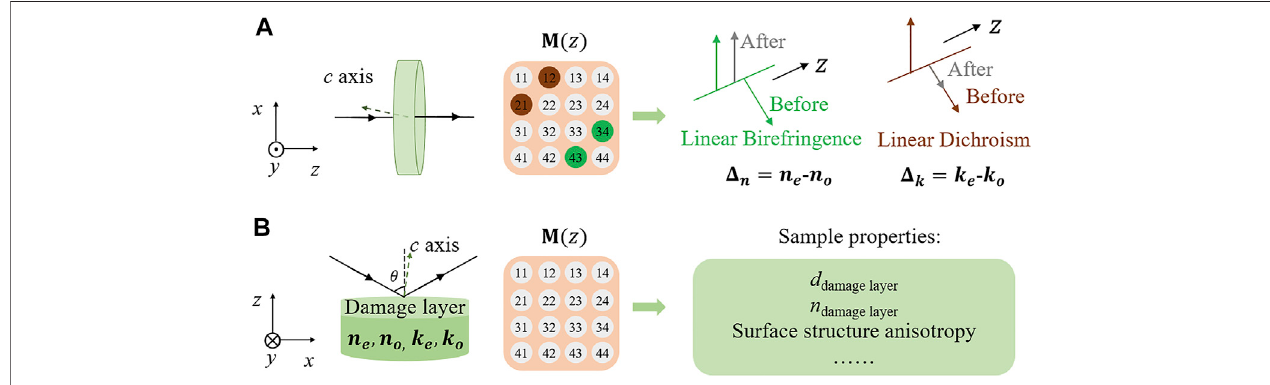
FIGURE 1 | (A) The transmission Mueller matrix measurement of off-axis cut uniaxial 4H-SiC wafer. The linear birefringence and linear dichroism can be analyzed. (B) There fl ectiveMuellermatrixmeasurementofprocessed4H-SiCwafer withthedamagelayer.Therefractiveindexandthicknessofthedamagelayerandthesurface structure anisotropy of the rough grinding wafers can be